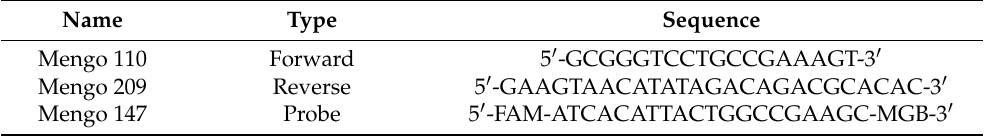
Table 2. Primers and probe used to detect mengovirus in One-Step RT Real-time